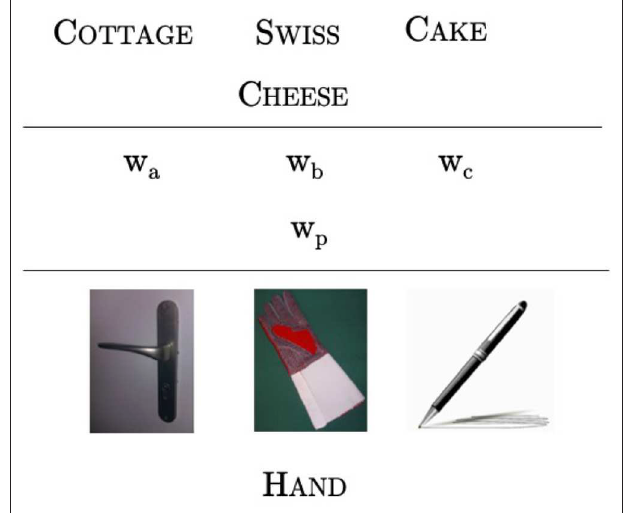
FIGURE 1 | Visual representation of the process of creation of vRAT queries. A linguistic query was formalized and then turned into a visual query. This particular vRAT query is the first training